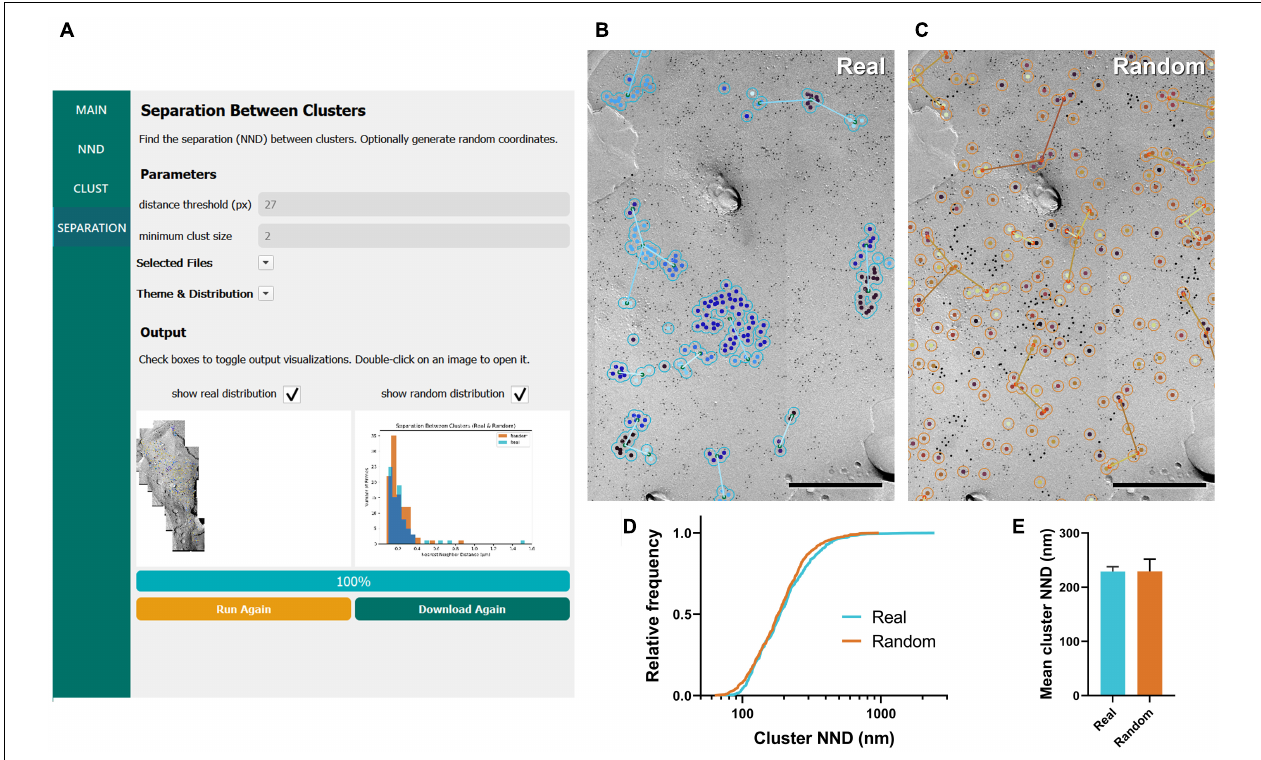
FIGURE 4 | GIO workflow result of gold particle cluster separation analysis of Ca V 2.1 at the calyx of Held. (A) GIO interface showing the cluster separation analysis workflow. Parameters show an additional field for setting the minimum cluster size, i.e., the minimum number of particles in a cluster. A labeled image of the ROI is displayed along with a histogram of the cluster nearest neighbor distances for real and/or random distributions. (B) The separation analysis output for real particles, showing the same portion of ROI as in Figure 2B . Lines are drawn connecting nearest clusters. (C) The separation analysis output for randomly distributed particles superimposed on the same portion of ROI. (D) Cumulative frequency distribution of real and random cluster NNDs pooled across the six ROIs. (E) Grand mean cluster NND. Error bars represent S.E.M. n = 6 ROIs. Scale bars: 500